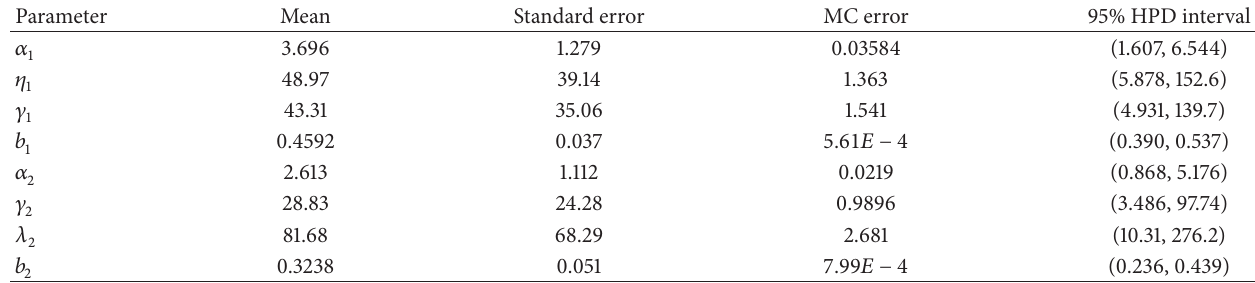
Table 3: Parameter estimation results without considering the dependency.